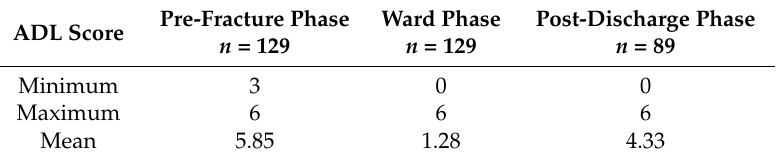
Table 5. Minimum scores, maximum scores and mean scores for all three phases.